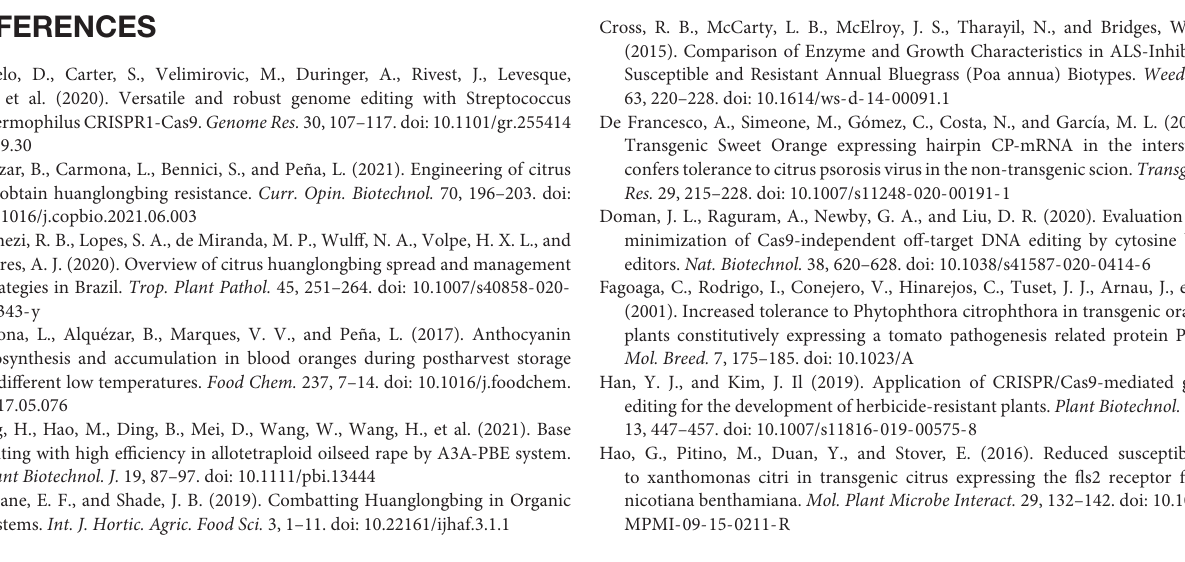
Supplementary Figure 3 | (A) T-DNAs used to generate transgenic imazapyr-resistant lines. Schematic diagram of the T-DNA regions of the pDGB3O2 vectors containing mutated versions of CsALS (ALSm1 and ALSm2) used for citrus transformation. LB and RB, left and right T-DNA borders, respectively; p35S, CaMV 35S promoter; ALS , mutated versions of CsALS CDS. Nucleotide changes in ALSm2 and ALSm1 are indicated; GUSint, β -glucuronidase